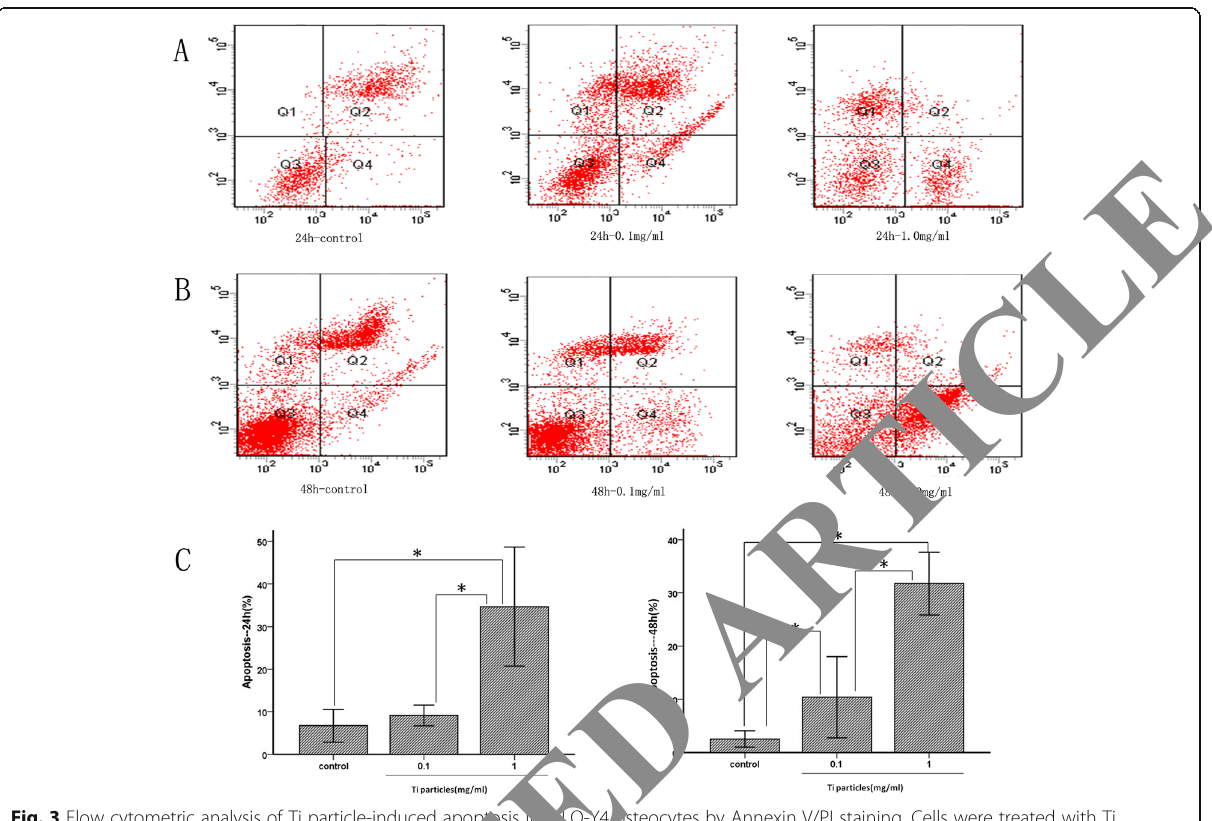
Fig. 3 Flow cytometric analysis of Ti particle-induced apoptosis in MLO-Y4 osteocytes by Annexin V/PI staining. Cells were treated with Ti particles (0 (control), 0.1 mg/mL, and 1.0 mg/mL) for 24 h ( a ) and 48 h ( b ), and stained with FITC-conjugated Annexin V. Apoptosis of cells was quantified by flow cytometry. Q4 represents apoptotic cells. c Data from ( a ) and ( b ) are as a percentage of apoptotic MLO-Y4 cells (mean ± SD). At 24 h, apoptosis rates of the cells exposed to 1.0 mg/mL Ti particles were higher than those of the control group and the 0.1 mg/mL group (* p < 0.05). At 48 h, rates of apoptosis were higher in cells exposed to 0.1 mg/mL or 1.0 mg/mL Ti particles than in the control group (* p < 0.05)